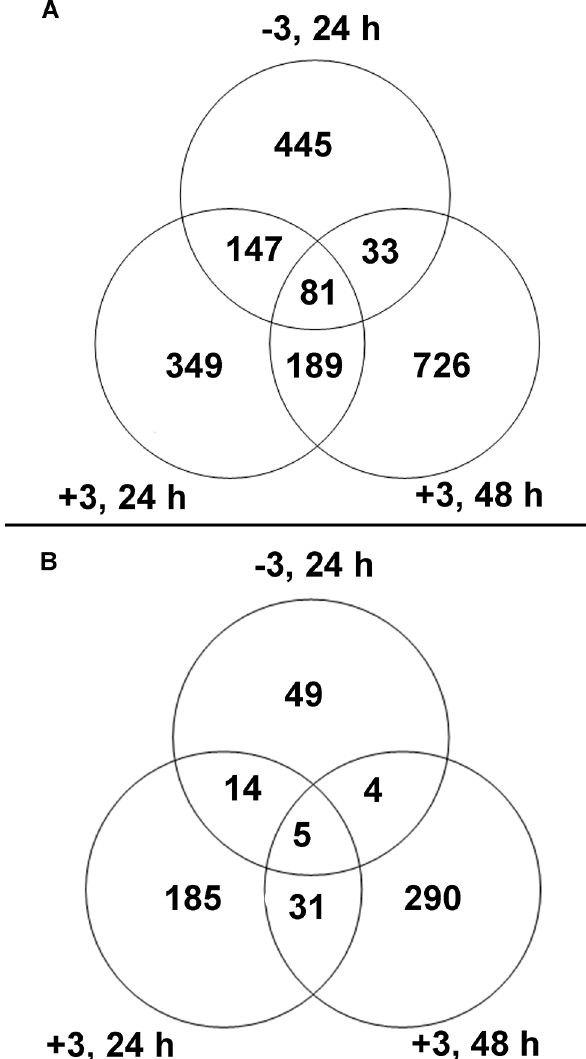
Fig 1. Numbers of genes in wheat crowns changing expression after exposure to the indicated temperature treatments. ( A ) Numbers of upregulated genes, ( B ) numbers of downregulated genes. All plants treated were exposed to − 3°C for 24 h; plants from the +3, 24 h and +3, 48 h treatments were subsequently allowed to thaw at +3°C for 24 or 48 h, respectively, after the